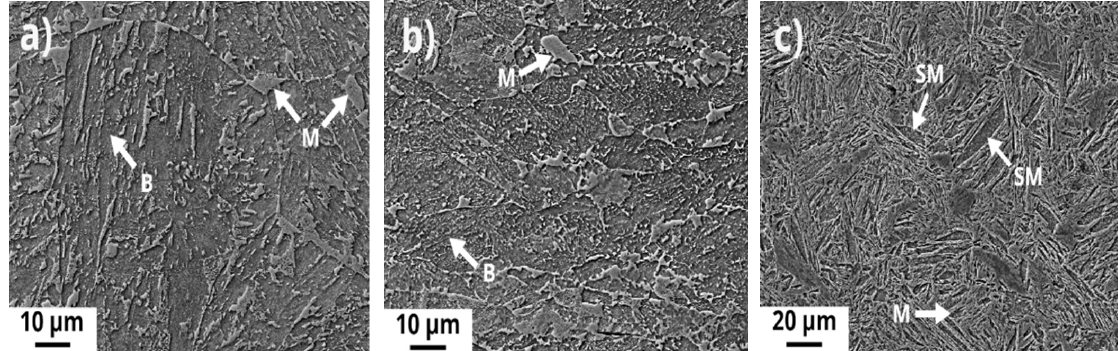
Figure 3. The microstructure of steel Ti–Nb for hot-forged, hot-rolled, and QT conditions. Marks “B”, “M”, and “SM” represent bainite, martensite, and self-tempered martensite, respectively. Etched state, SE image on FE-SEM. ( a ) Hot-forged; ( b ) hot-rolled; ( c ) QT.